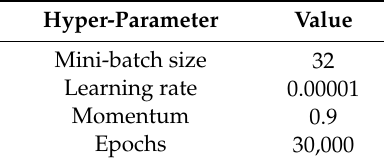
Table 2 lists the hyper-parameter setup used to train the proposed RefineNet-PPCRF. In the comparison experiments, the hyper-parameters were also applied to the comparison model. Table 2. The hyper-parameter setup.